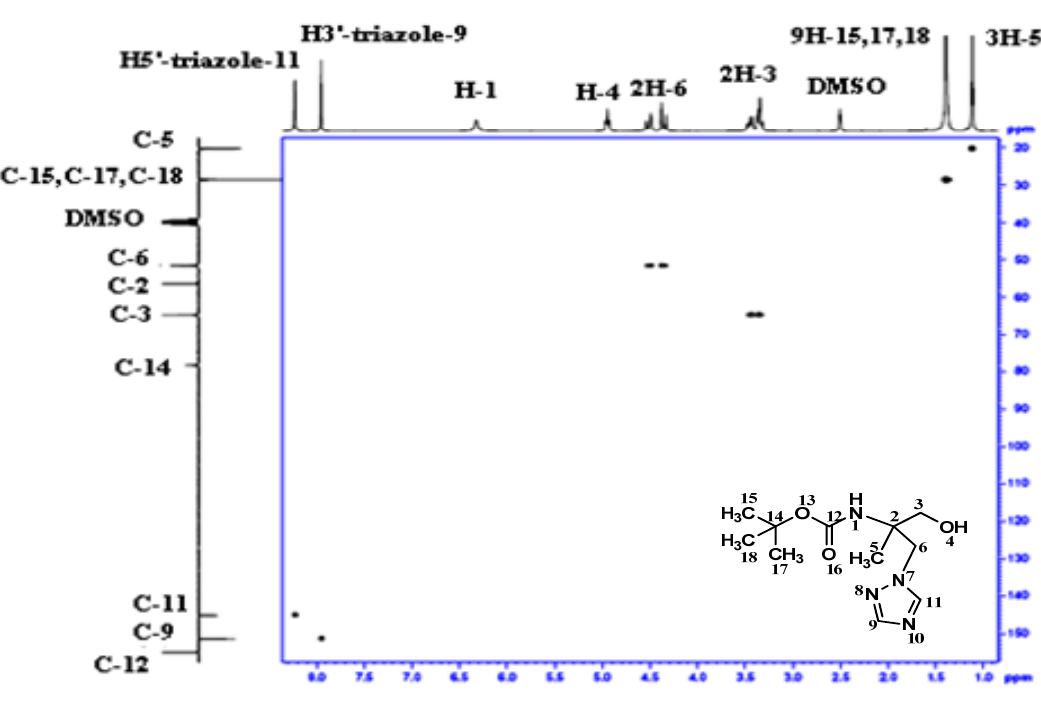
Figure 3. Heteronuclear 1 H- 13 C 2D spectrum for compound 4.